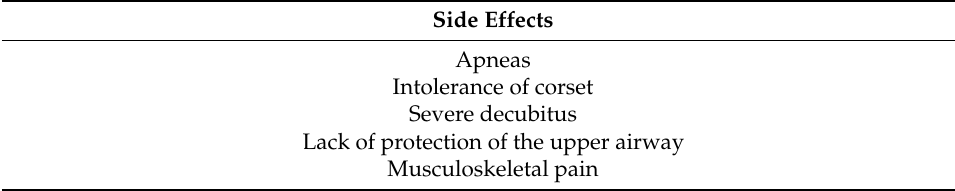
Table 3. Side effects of